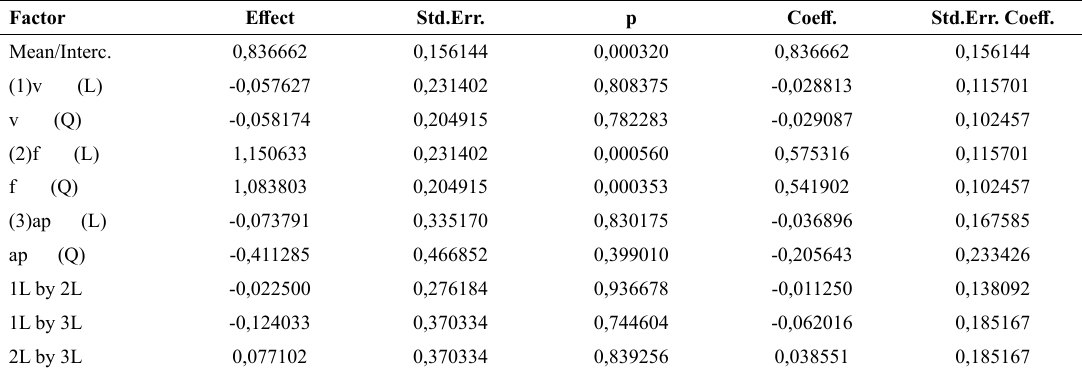
Table 4. ANOVA for the effect of the independent variables on roughness